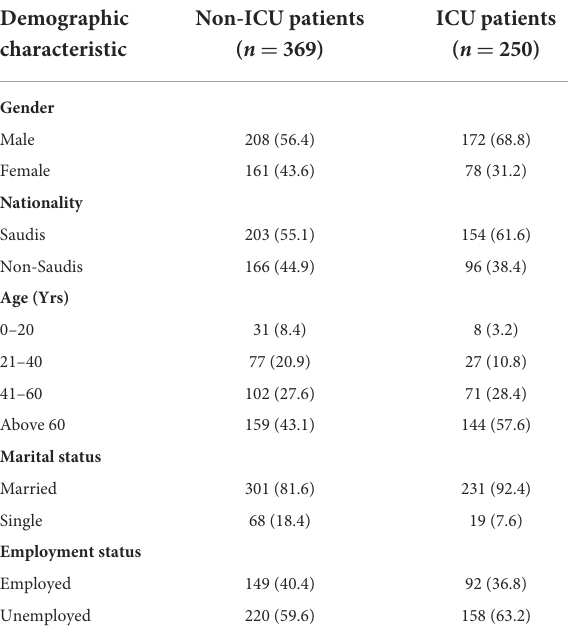
TABLE 2 Clinical characteristics of hospitalized COVID-19